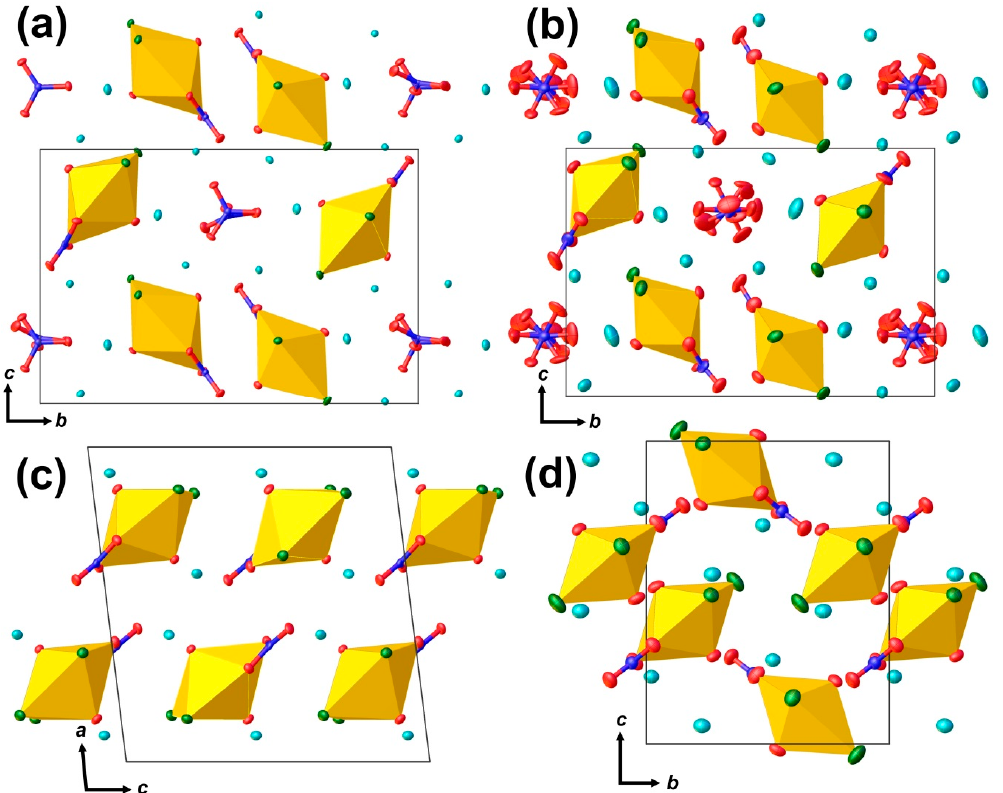
Figure 3. Crystal structures of 1 ( a ), 2 ( b ), 3 ( c ), and β -Cs 2 [(UO 2 )(NO 3 )Cl 3 ] [15] ( d ). Legend: see Figure 2; K and Cs atoms = cyan.